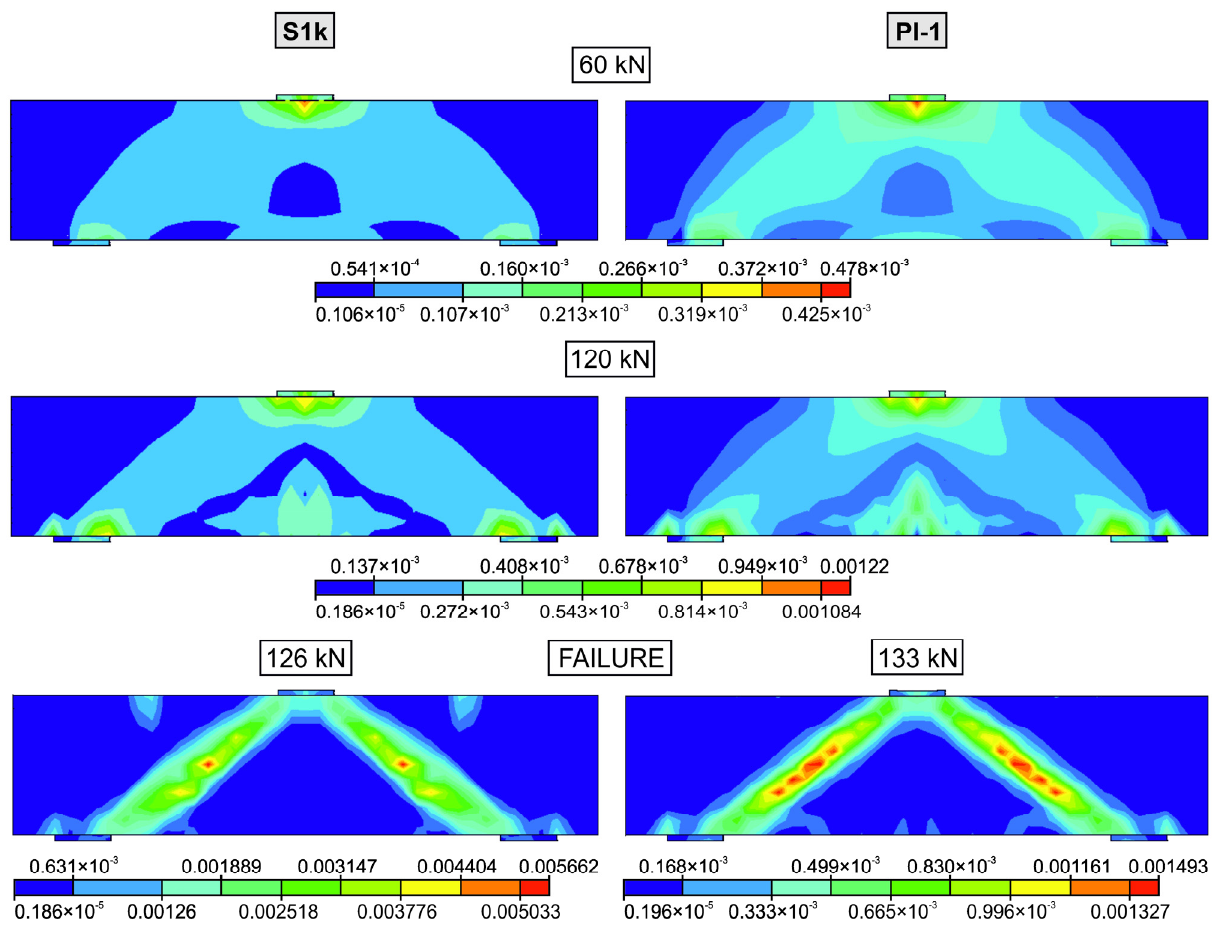
Figure 14. Comparison of strain intensity for the short beams PII-1 (2 ϕ 12, f y = 548 MPa) and PI-1 (2 ϕ 18, f y = 548 MPa).